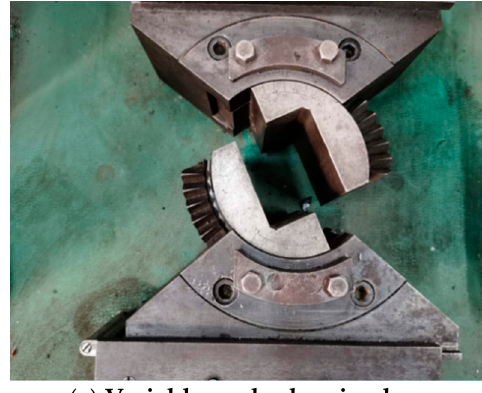
Figure 4. Shear moulds and TSL samples.